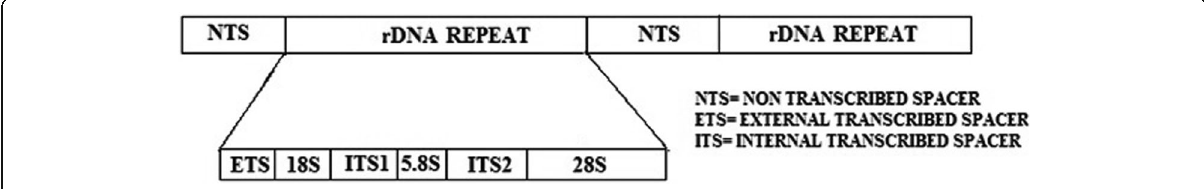
Fig. 1 Genetic alignment of eukaryotic ribosomal